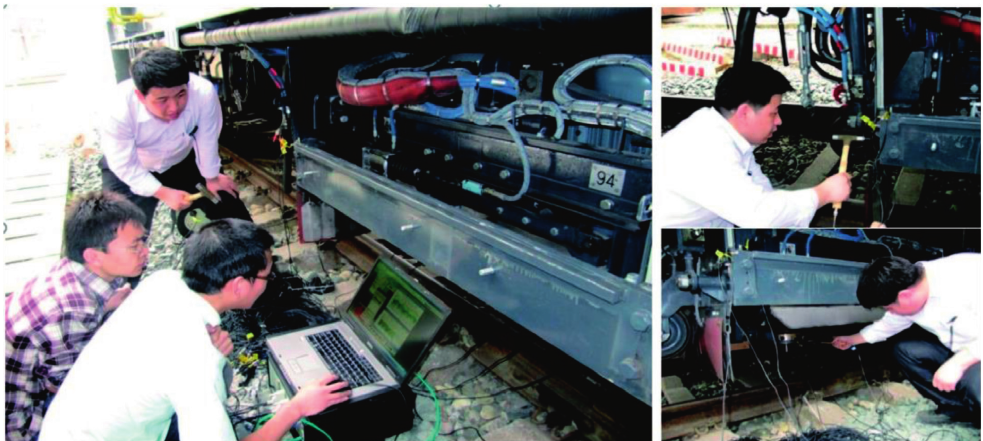
Figure 15: On-site vibration test of a rail-grinding train.